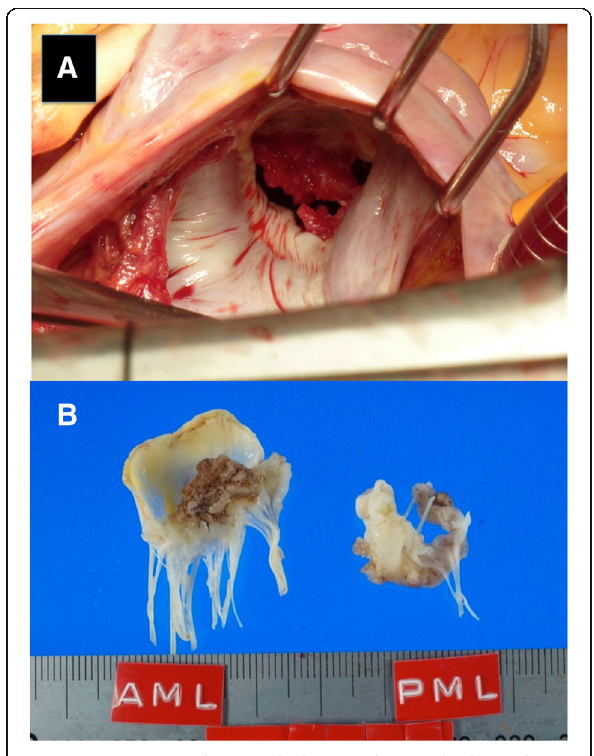
Fig. 1 Intraoperative photograph showing the mitral valve and vegetation on the both mitral leaflets ( a ). Representative photographs of the extracted mitral leaflets ( b )